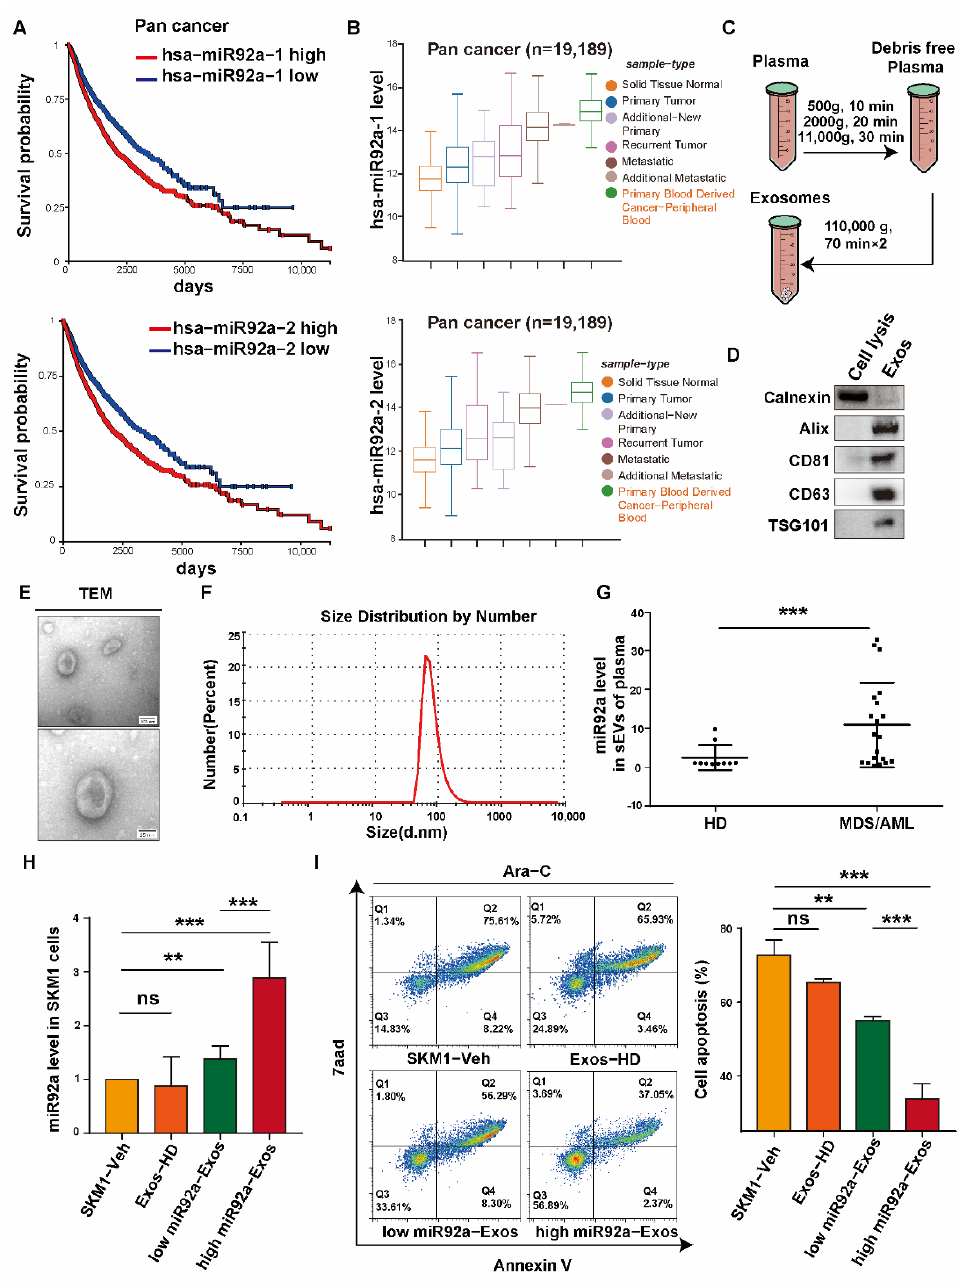
Figure 1. Exosomal miR92a is upregulated in MDS/AML plasma. ( A ) Kaplan–Meier survival analysis of patients with pan cancer was conducted according to the expression of miR92a1/2 using the log-rank test via the TCGA database. ( B ) miR92a1/2 level in different types of cancer analysis by TCGA database. ( C ) The scheme of exosome isolation from plasma. ( D ) Detection of Exo markers by Western blotting. ( E ) Examination of Exo morphology by TEM. ( F ) Particle size of Exos by NTA. ( G ) Expression of exosomal miR92a in plasma derived from healthy donors (HD, n = 10) and MDS/AML patients (MDS/AML, n = 20). ( H ) The ratio of miR92a level in patient plasma to miR92a level in healthy donor plasma ≥ 2 was considered as high Exos-miR92a, and <2 was considered as low Exos-miR92a. miR92a level in SKM1 treated by Exos-HD, Exos-miR92a high and Exos-miR92a low. ( I ) Apoptosis of SKM1 treated by 2 μM Ara-C and 10 μg Exos-HD, high Exos-miR92a and low Exos-miR92a for 48 h analyzed by flow cytometry. Ns ≥ 0.05, ** P < 0.01, *** P < 0.001 .